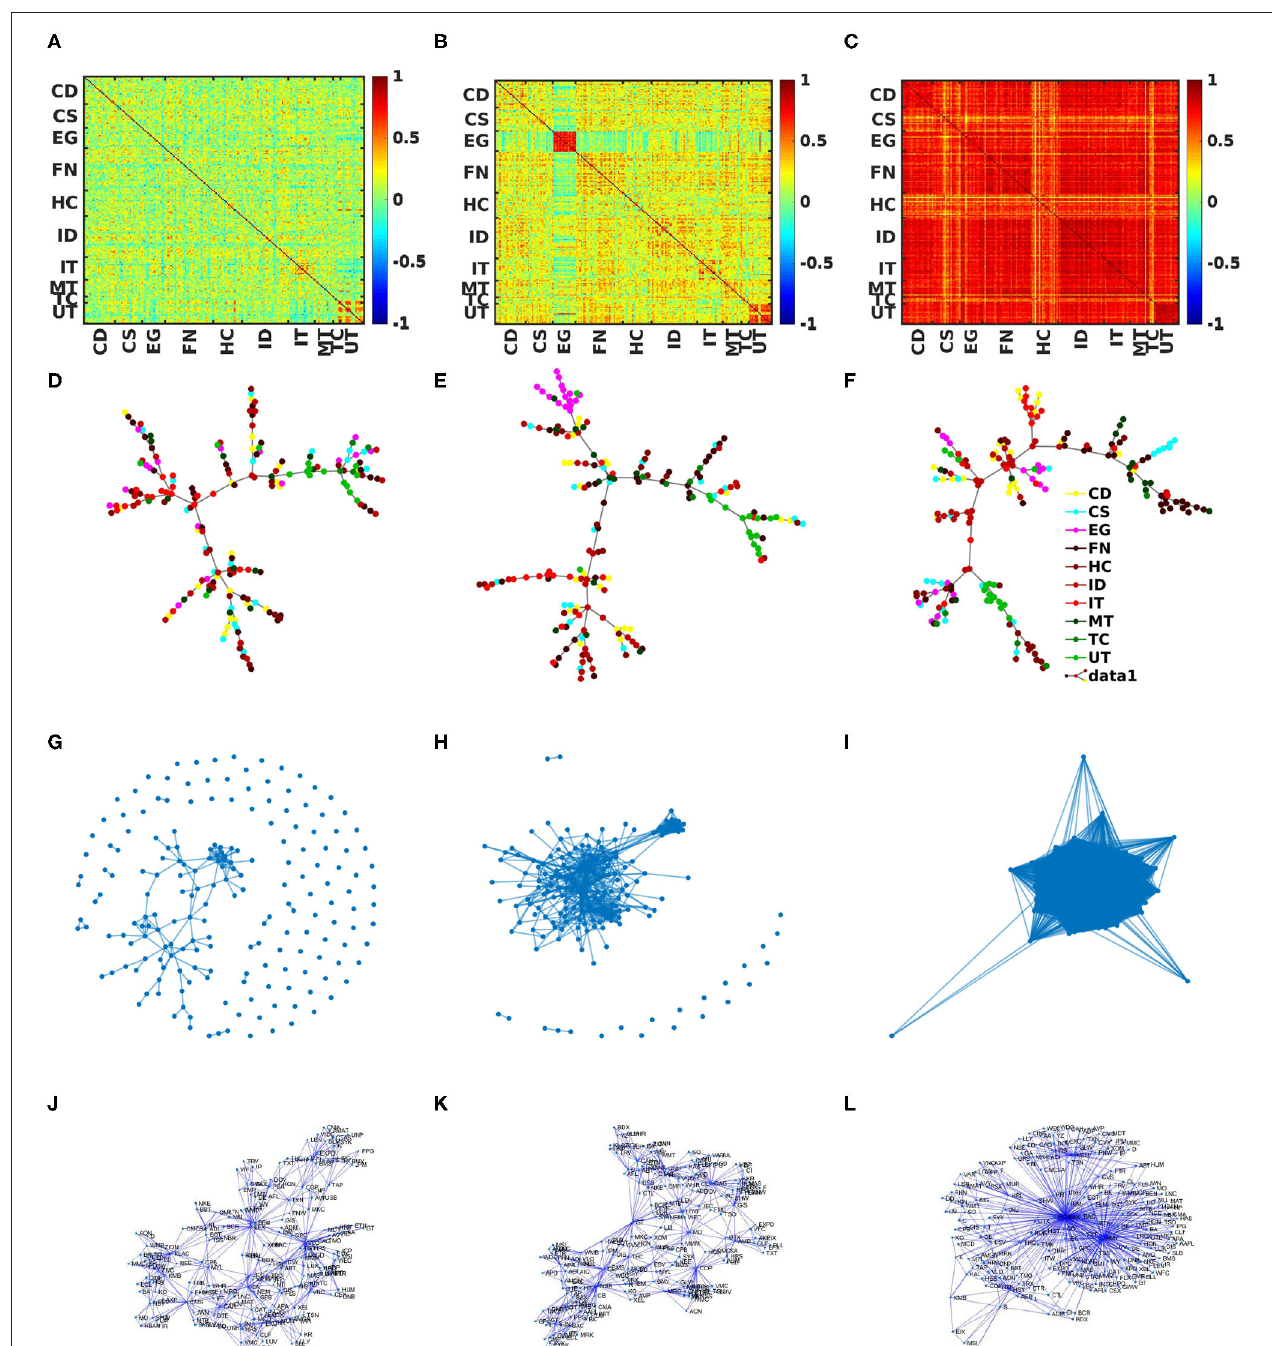
FIGURE 1 | Static correlation-based networks: Analysis of S&P 500 market with 194 stocks (epoch of 40 days) for three different periods: first, second, and third columns are corresponding to 23/07/1985 (normal period), 08/01/2007 (bubble period), and 17/06/2010 (crash period), respectively. (A–C) are heat maps of correlation matrices of different periods. Minimum Spanning Trees are shown in (D–F) . From (G–I) , Threshold Networks at a particular value of threshold. Planar Maximally Filtered Graphs (J–L) for three different periods.